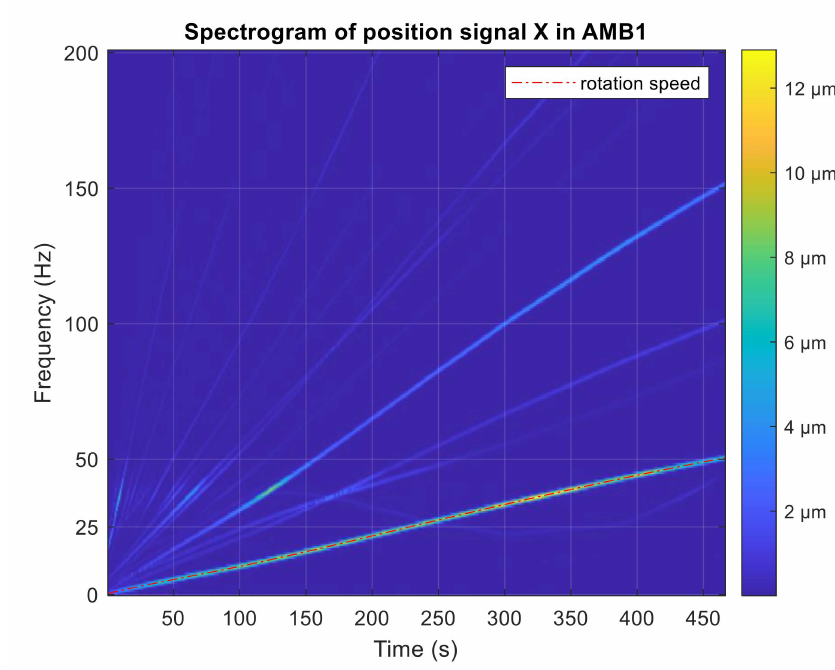
Figure 13. STFT spectrogram of position signal during run-up without